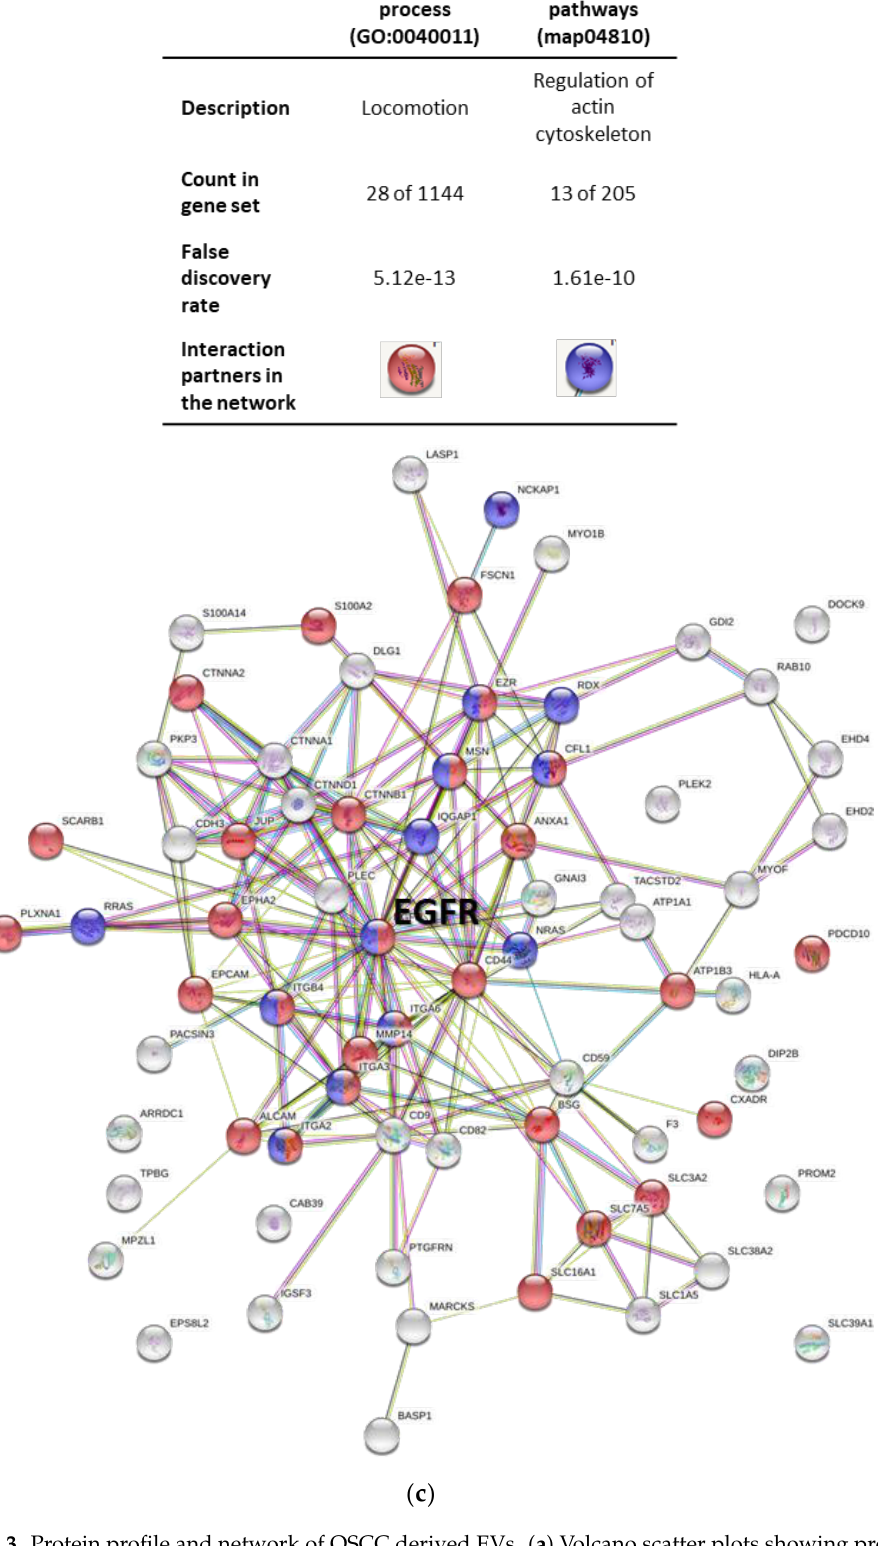
Figure 3. Protein profile and network of OSCC derived EVs. ( a ) Volcano scatter plots showing proteins with differential expression in the EVs derived from OSCC cells. ( b ) Venn chart depicted the overlapping of the differentially expressed proteins in EVs (all published in Vesiclepedia) derived from three OSCC cell lines. ( c ) Networks of proteins which downregulated in the EVs derived from cisplatin-resistant OSCC cells (STRING database: https://string-db.org/).